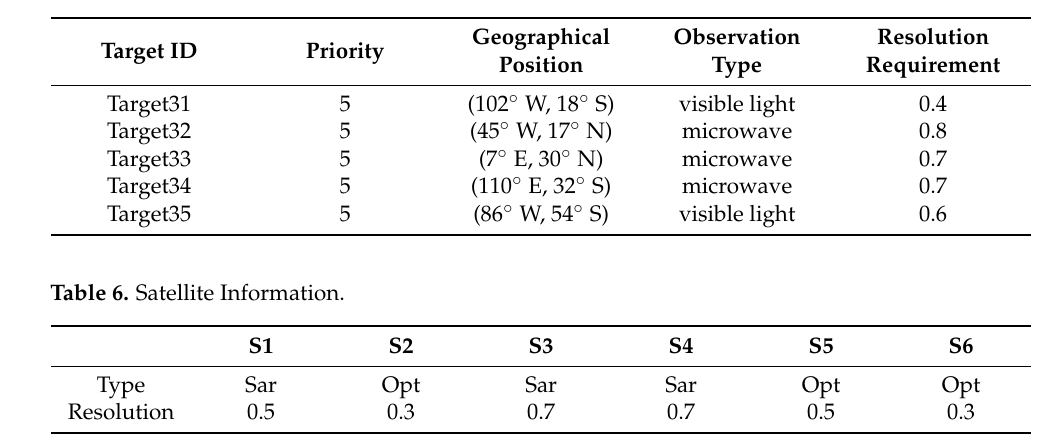
Table 5. Emergency targets parameters.